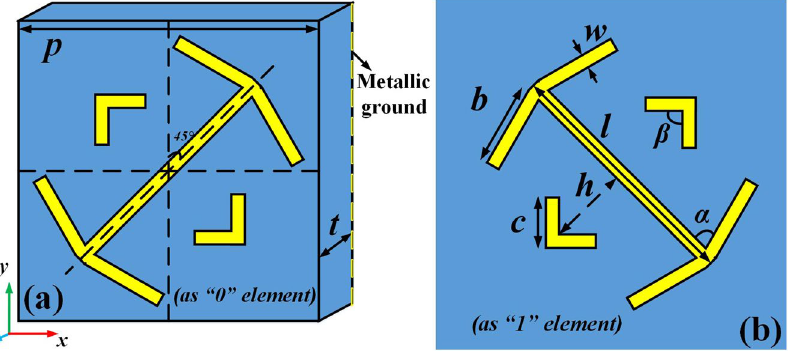
Figure 1. Front views of “0” and “1” element unit cells. The unit cell structure with an angle of 45° to the y-axis represents the “0” element ( a ), and the structure rotated 90° counter-clockwise about the z-axis is the “1” element ( b